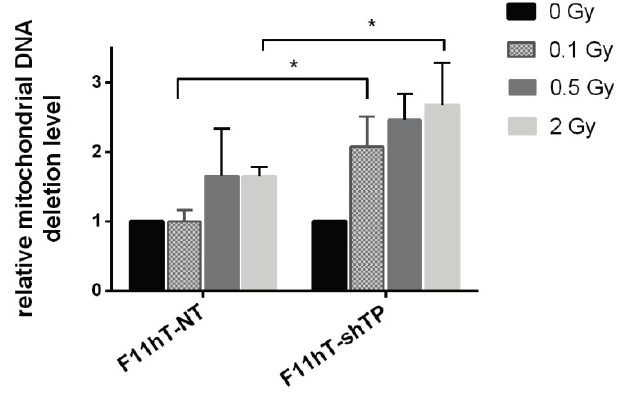
Figure 5. Effect of TP53inp1 silencing on the accumulation of CD (common deletion) in the mitochondrial genome. Dose-dependent increase of mitochondrial common DNA deletions was compared in irradiated F11hT-NT and F11hT-shTP cells by qPCR. The mean ± SEM